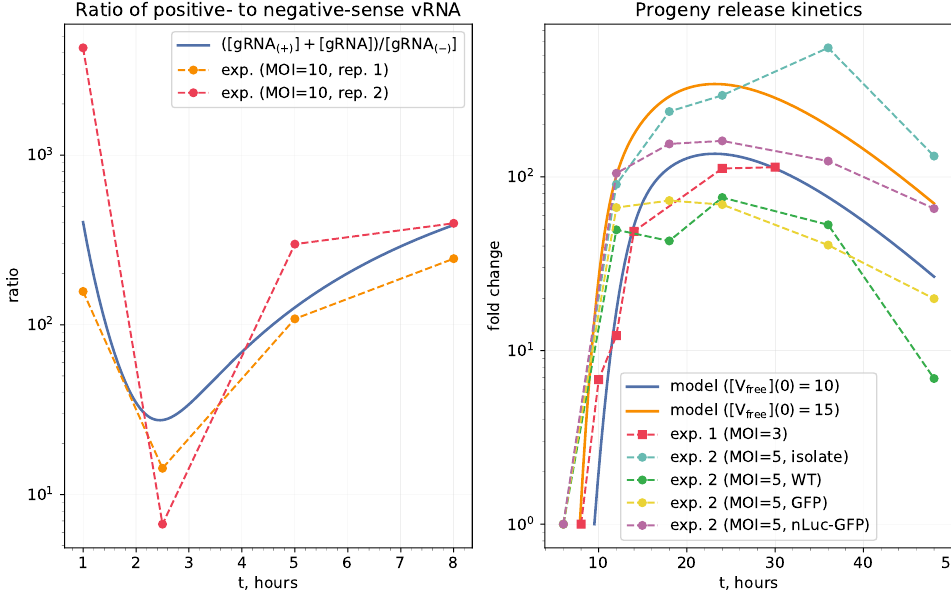
Figure 3. Validation of the calibrated model against available experimental data. ( Left ) ratio of positive- to negative-sense vRNA predicted by the model and measured in MHV-infected cells at MOI = 10 in [24]. ( Right ) SARS-CoV-2 progeny release kinetics in Vero E6 cells from [23,25] expressed in fold changes of the titer levels in cell culture from the start of their exponential growth. For model predictions, the moment of release onset was defined as the moment t s at which [ V released ]( t s ) = 1. The initial conditions were chosen to match the MOI used in experiments, i.e., so that the maximum number of uncoated [ gRNA (+) ] ≈